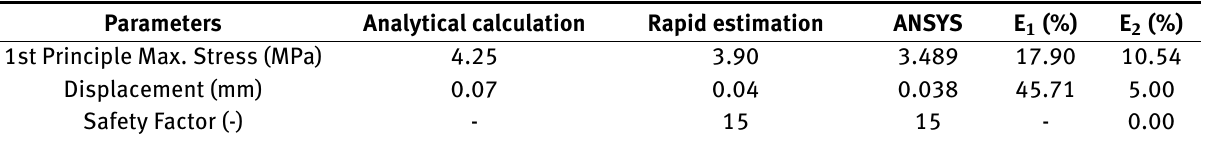
Table 3: Error comparison of the analytical calculations, rapid estimation (Autodesk Inventor) and ANSYS: part of driver leg